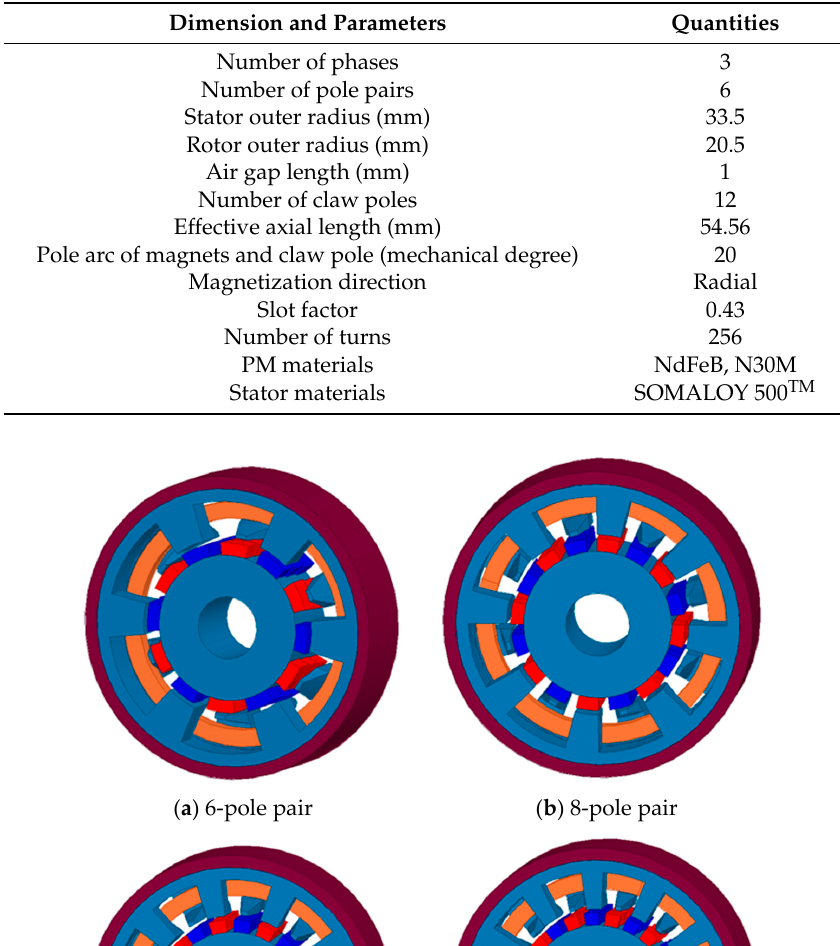
Figure 1. Topology of the initial claw pole machine, ( a ) stator, ( b ) rotor. Table 1. Dimension and key parameters.